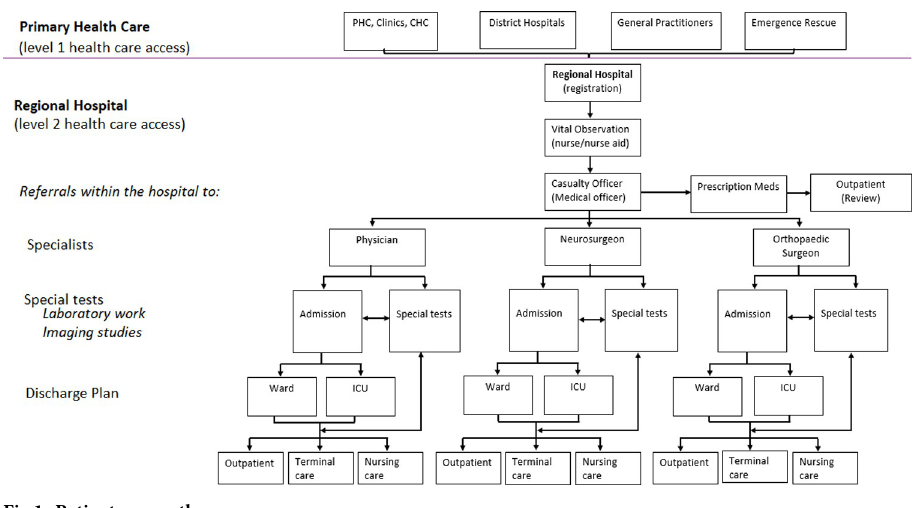
Fig 1. Patient care